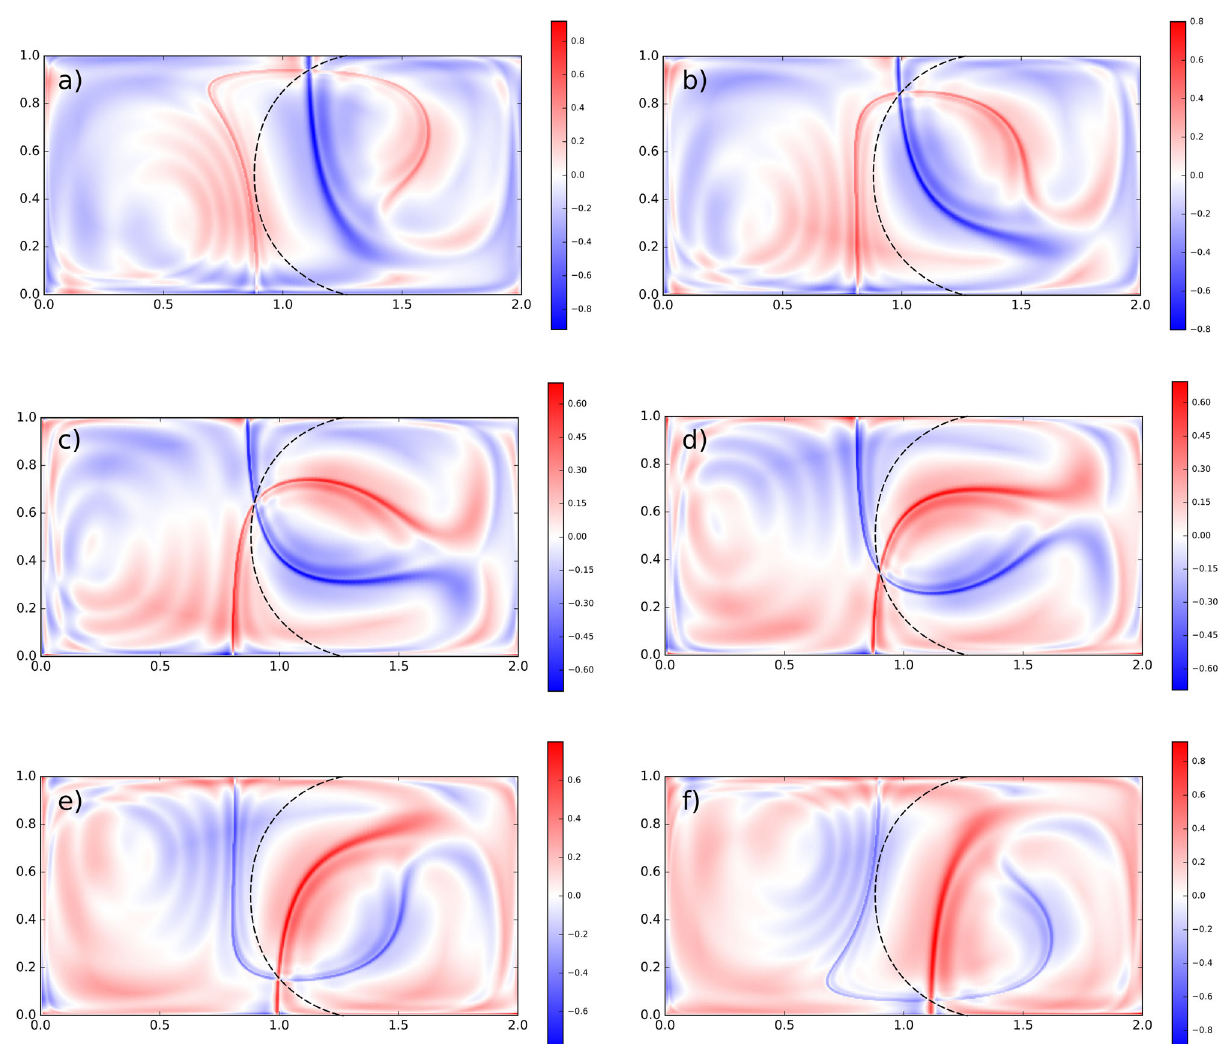
Fig. 5 Finite-time Lyapunov exponents (FTLEs) fi elds in the doube-gyre. a – f Superimposition (by difference) of forward (red) and backward (blue) FTLEs fi elds for the double-gyre fl ow at different intermediate times ( t = 5, 6, 7, 8, 9, 10) and matching the time interval [0, 15]. The dashed black line is the B L ridge of Fig. 4. We clearly see the moving location of a hyperbolic trajectory, detected by the intersection of both main ridges in backward and forward FTLE, changing its position for different intermediate times. Such hyperbolic trajectory matches perfectly the B L